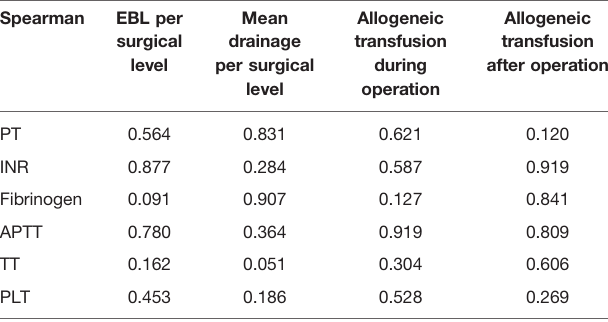
TABLE 3 | Spearman correlation analysis.